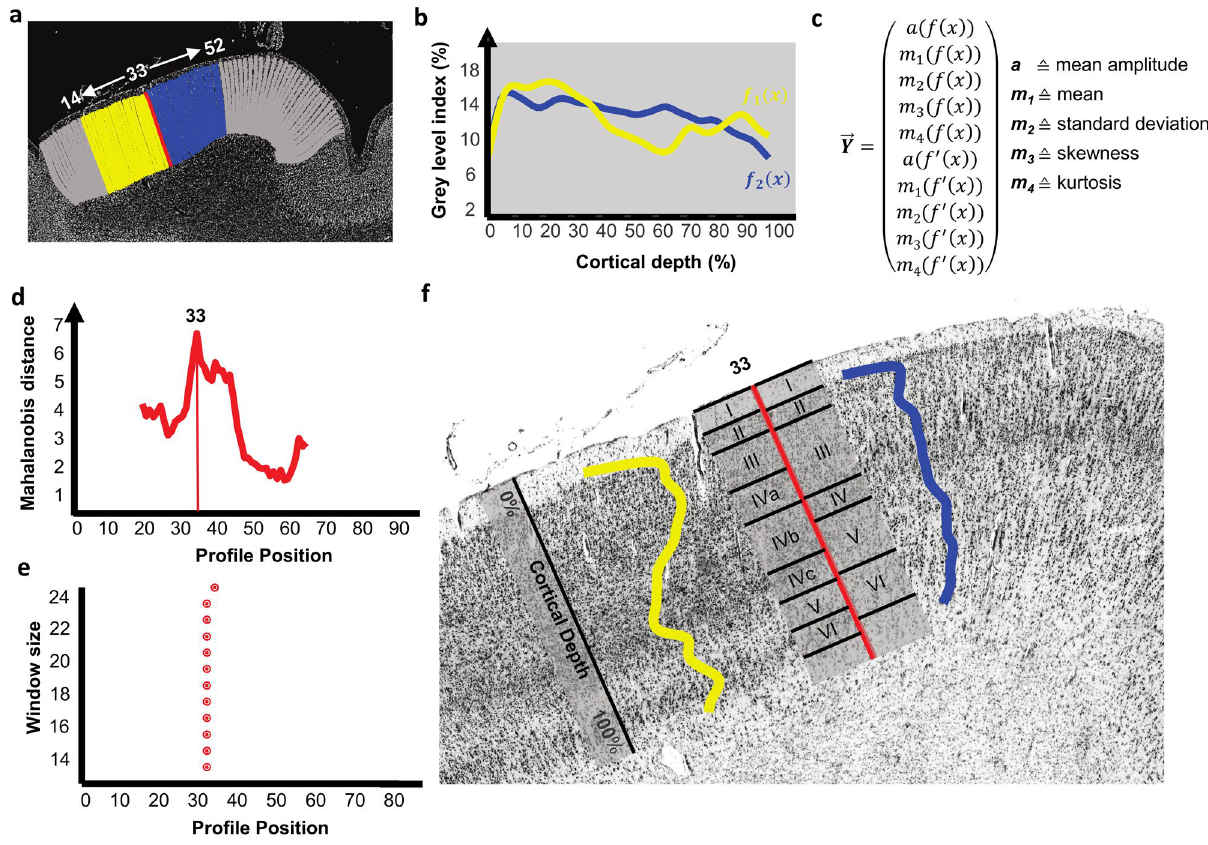
Figure 2. Illustration of the GLI profile approach for cytoarchitectonic analysis 19–21,23,47 . ( a ) shows profiles (19 yellow and 19 blue) around a target profile (red, number 33) on a GLI image of a region of interest in the occipital lobe of the BigBrain dataset 28 . The graph in ( b ) depicts mean profiles from each of the 19 profiles from ( a ). ( c ) shows the feature vector used to quantify the shape of the mean profiles in ( b ) by interpreting them as frequency distributions. The feature vector consists of the mean amplitude of the distribution, the first 4 central moments as well as the first derivatives of the later. ( d ) illustrates the multivariate Mahalanobis distance metric between feature vectors generated from a sliding window approach with window size 19. It indicates a significant global maximum of differences between feature vectors at profile position 33. Significant global maxima for different window sizes in ( e ) confirm the detection of a border at position 33. ( f ) shows the detected border (red bar) displayed on the histological section used in ( a ). Roman numerals indicate cortical layers. Superimpositions of the profiles from ( b ) reveal correspondences to cytoarchitectonic features and reflect differences in lamination and cellular composition between cortical area hOc1 on the left and hOc2 on the right side of the detected border 25 . These include a clear differentiation of cortical layer IV reflected by differences in GLI profile shapes, as well as differences in the excess of the profile shapes at cortical depths relating to cortical layer IVc to VI in area hOc1 and IV to VI in area hOc2. In area hOc1, the broad and cell-dense cortical layer IVc contrasts the cell-sparse layer V which in return can easily be distinguished from the darkly stained layer VI. Whereas in area hOc2 the thinner cortical layer IV does not stand out from the less distinguishable layer V and VI to the same amount in the GLI profile